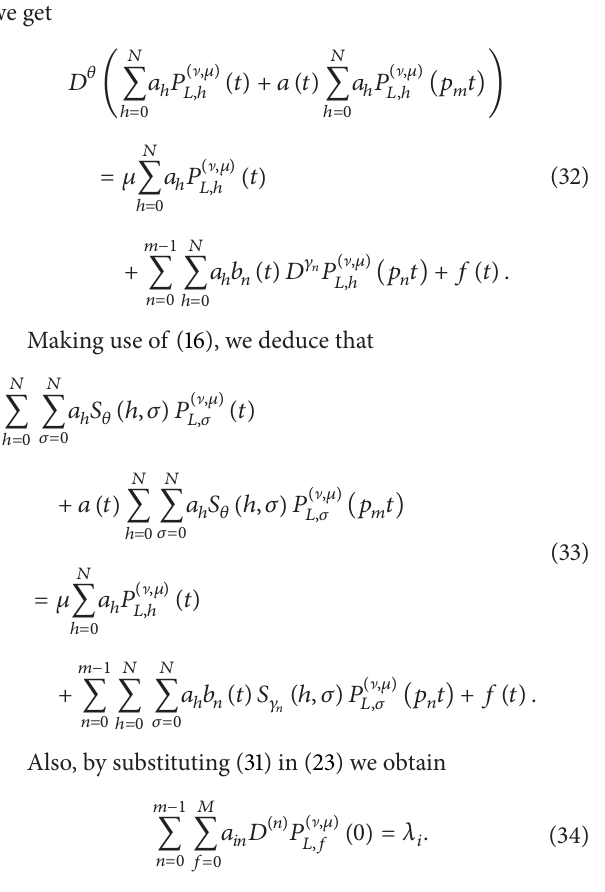
Table 1: Absolute errors using SJGC method at 𝑁 = 16 for Example